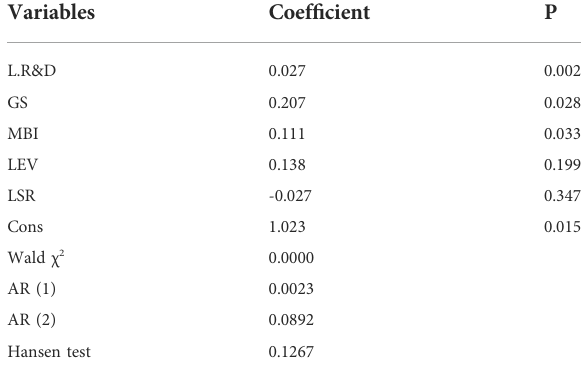
TABLE 7 Regression results of R&D investment.